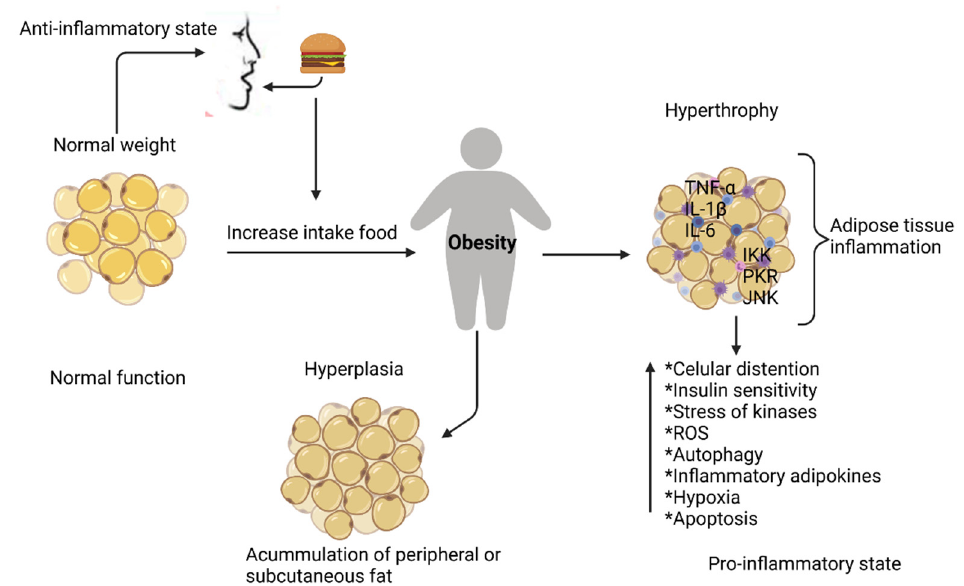
Figure 1. Adipose tissue inflammation. Excessive growth of adipose tissue in obesity induces the production of pro-inflammatory cytokines that activate protein kinase pathways, at the same time stimulating macrophage infiltration and a change in the phenotype of M2-type macrophages to proin- flammatory M1, leading to an inflammatory state with consequences locally and systemically. Tumor necrosis factor-alpha (TNF- α ), interleukin-1b (IL-1 β ), interleukin-6 (IL-6), N-terminal c-JUN (JNK), nuclear factor-kappa kinase inhibitor β (IKK), protein kinase R (PKR). Created with